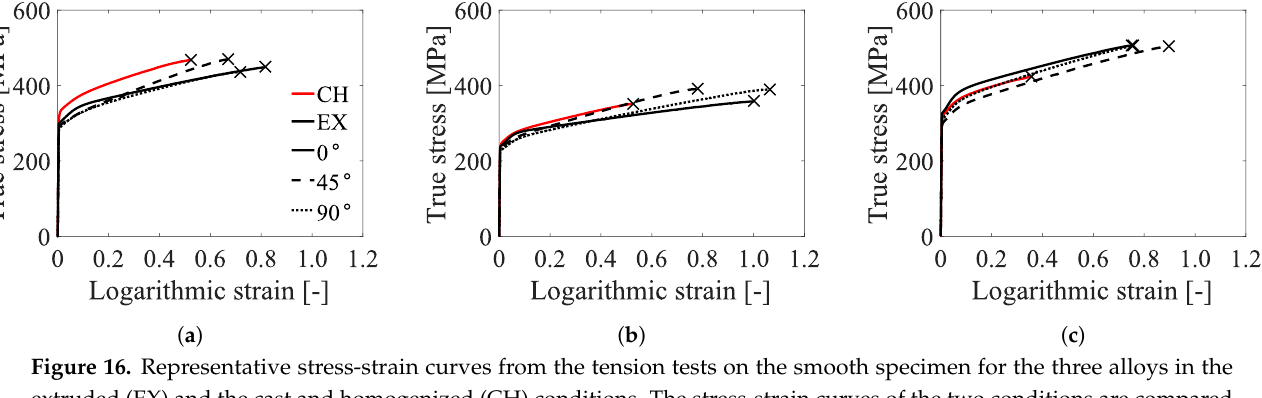
Figure 16. Representative stress-strain curves from the tension tests on the smooth specimen for the three alloys in the extruded (EX) and the cast and homogenized (CH) conditions. The stress-strain curves of the two conditions are compared for each alloy: ( a ) AA6061, ( b ) AA6063 and ( c ) AA6110. The legend in sub-figure ( a ) is valid for all